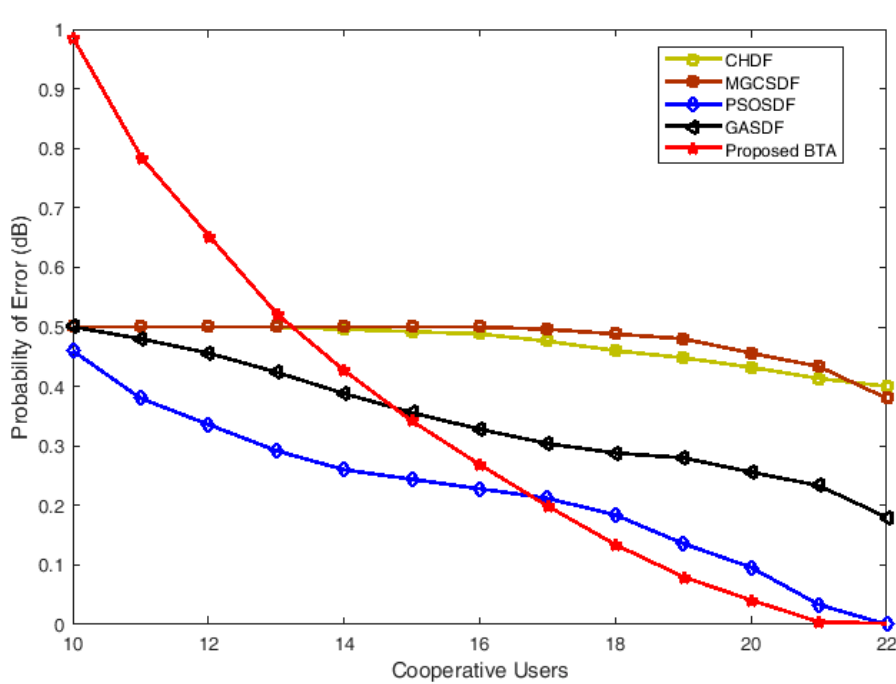
Figure 14. Probability of error vs. cooperative users with opposite MUs.